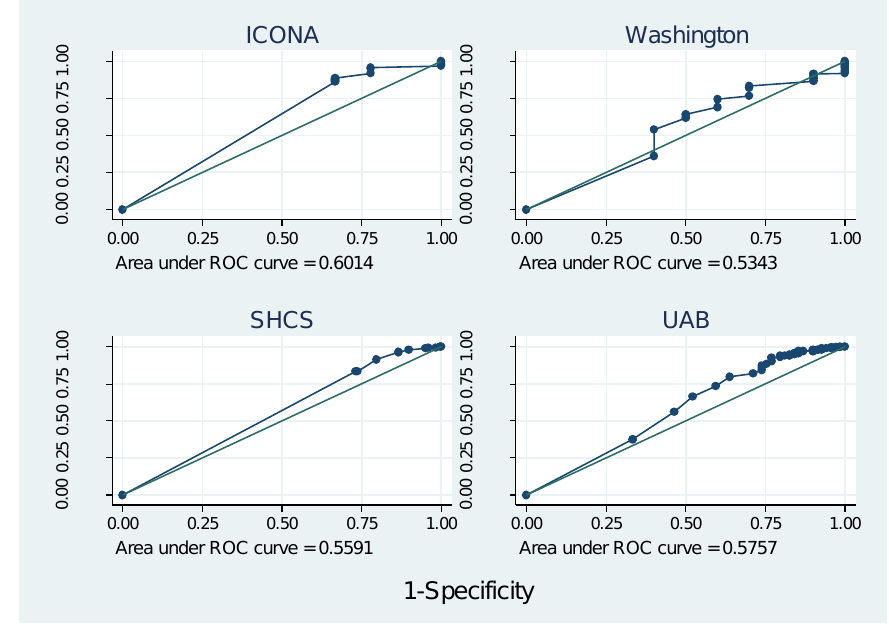
Figure 4. ROC curves for cohorts with self-report data.